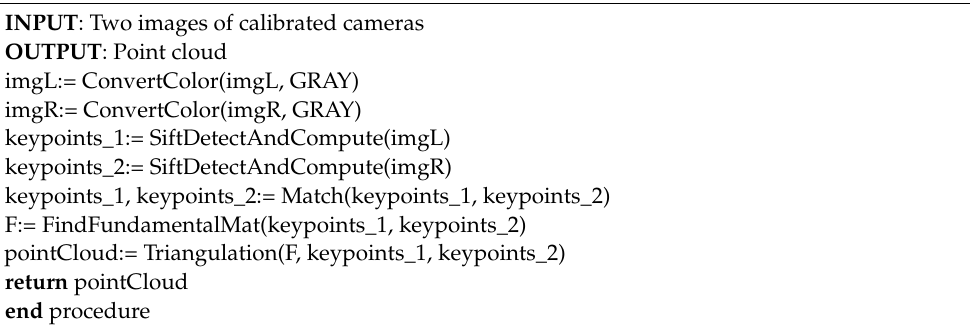
Algorithm 1. Calculation and presentation of points of a three-dimensional controlled